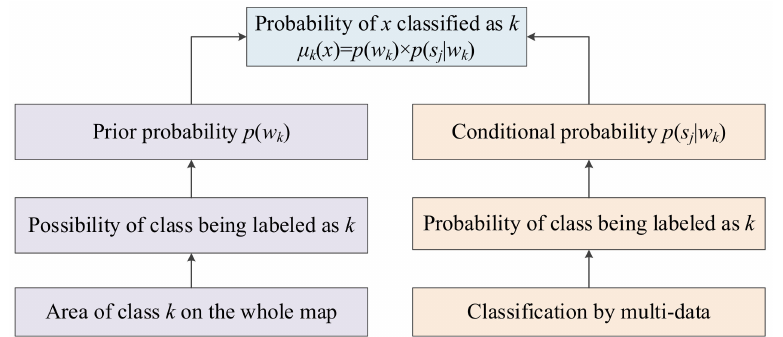
Figure 1. General workflow of the proposed method. The area of class k on the map denotes the possibility of k appearing on the whole map, thus used as prior probability in the Bayesian decision fusion formula. The multidata classification results are treated as the conditional probability of the x labeled as k after being carefully